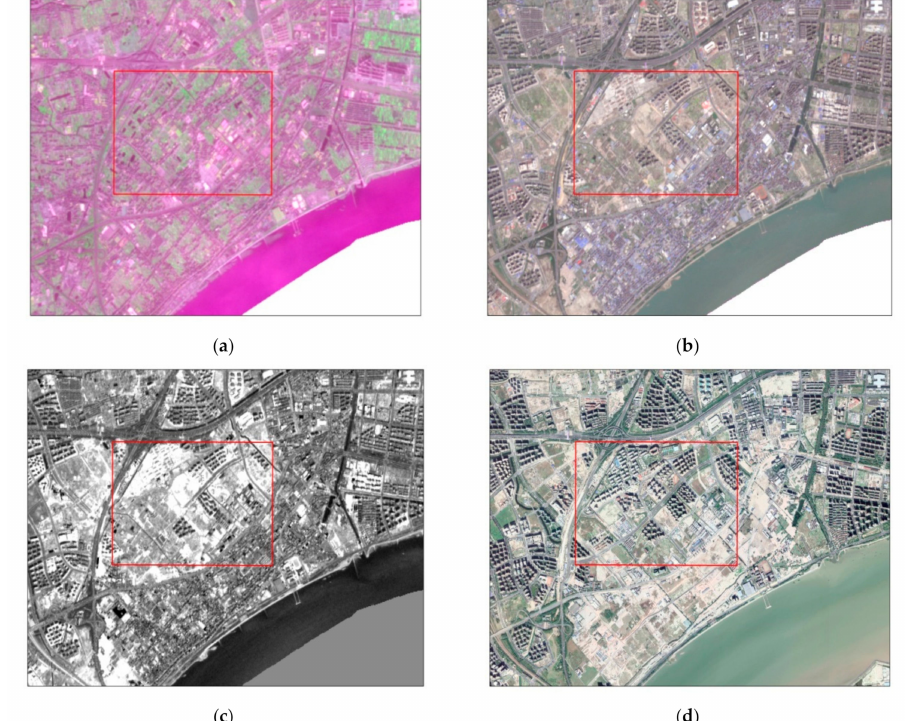
Figure 3. Example of Principal Component Analysis (PCA)-enhanced land use change information from cropland and water to urban land in the third principal component (PC3), 2006–2016. ( a ) Red, Green and Blue (RGB) composition image of SPOT-5 (2006); ( b ) RGB composition image of Sentinel-2A (2016); ( c ) the third principal component; ( d ) GF-2 image (2016).